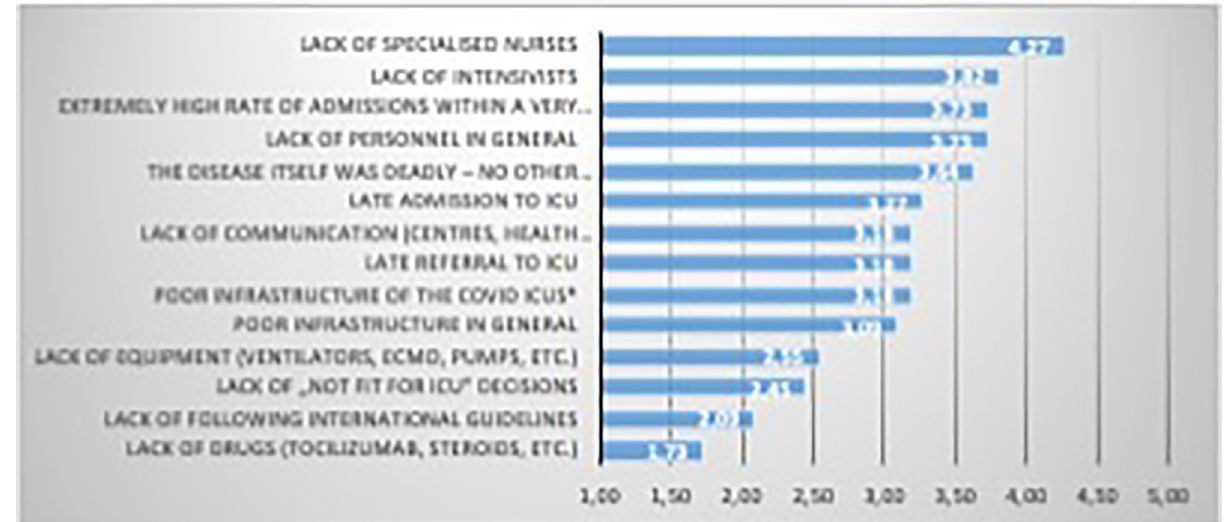
Figure 5. Factors subjectively associated with unfavourable outcome. Results of the survey among participating centres are presented for each factor as weighted average of the following rating: not important (1), slightly important (2), important (3), fairly important (4), very important